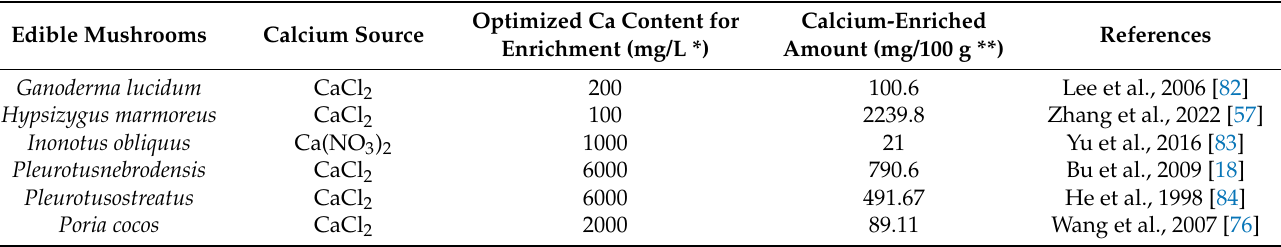
Table 2. Calcium enrichment in some edible